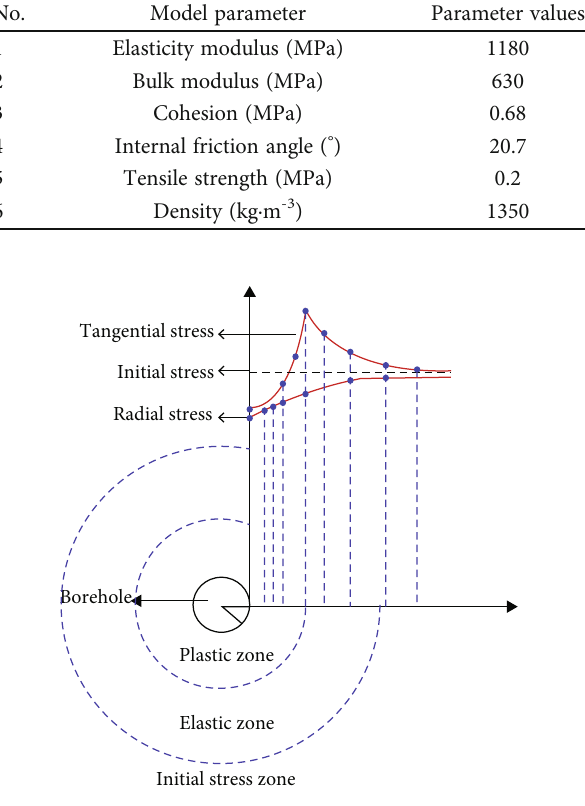
Figure 3: Stress distribution law around the